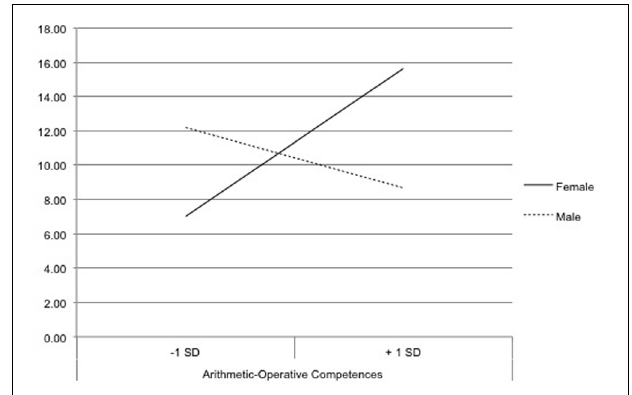
FIGURE 4 | Interaction effect between gender and arithmetic-operative competences on the participants’ mental effort.